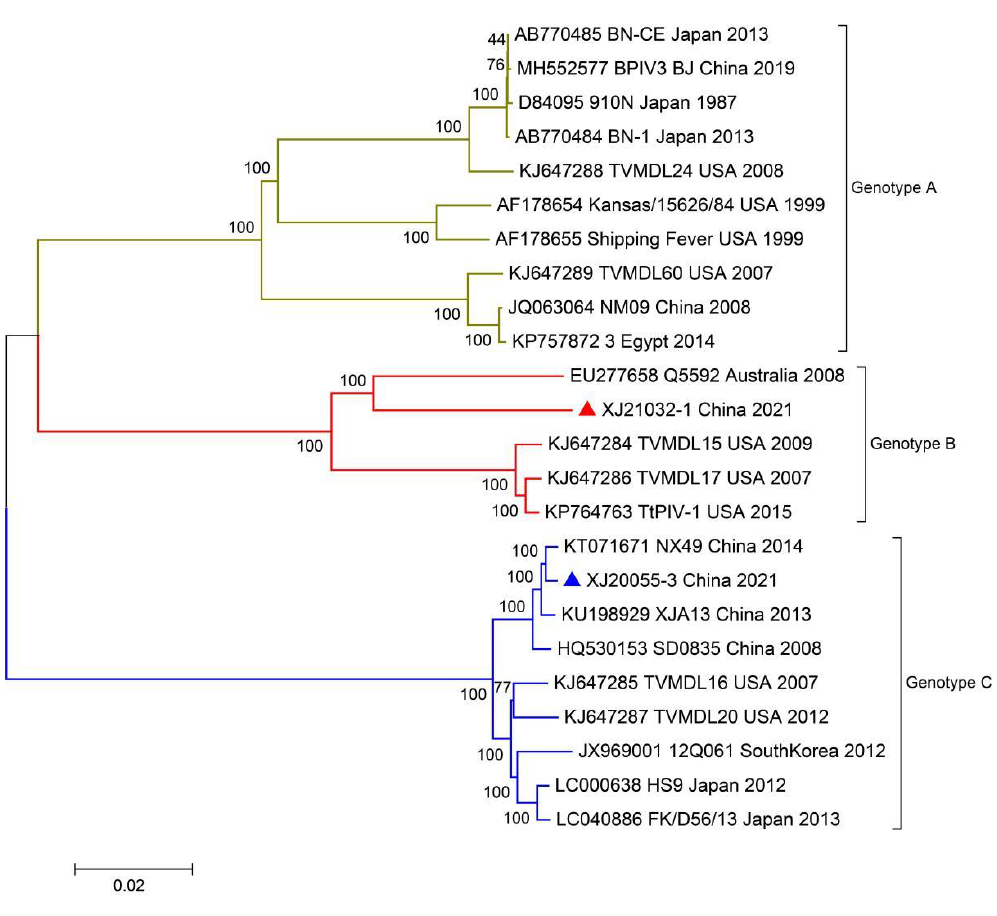
Figure 4. Phylogenetic analysis tree for the XJ21032-1 and XJ20055-3 isolates. In conjunction with other reference strains, the whole-genome nucleotide sequences of the XJ21032-1 and XJ20055-3 isolates were used to construct phylogenetic analysis trees using the NJ MEGA method 7.0 software. The lengths of the horizontal lines represent the genetic distance. The numbers at the nodes indicate the bootstrap percentage obtained after 1000 bootstrap replicates. Our isolates are marked with triangles. Table 2. Amino acid differences between F, HN, and N